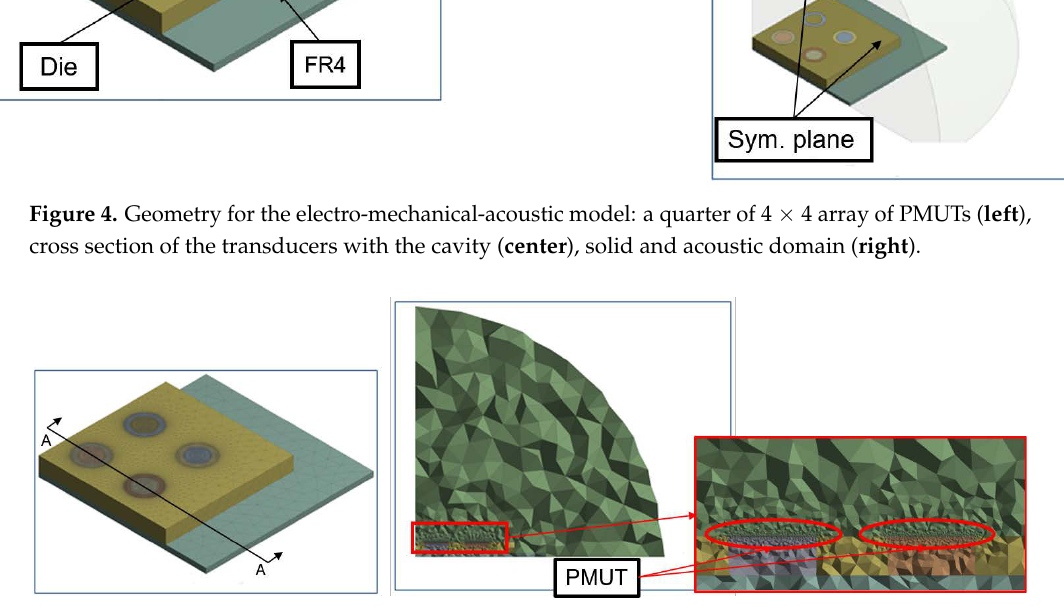
Figure 5. Mesh details: solid domain ( left ), vertical cross-section along A-A of the solid and acoustic domains ( center ), structure-acoustic interface ( right